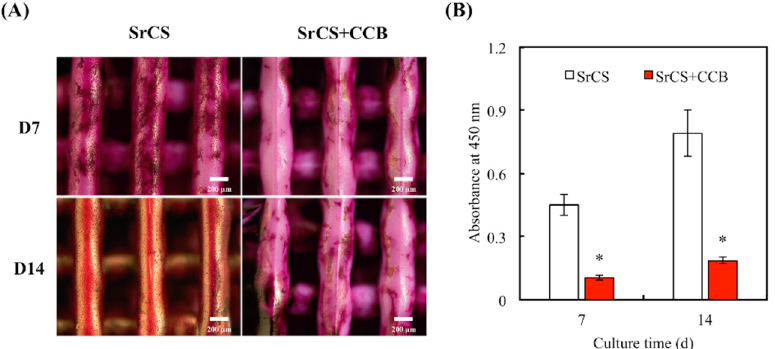
Figure 7. Proteins of ( A ) Col I, ( B ) OPN, and ( C ) OC secretion by WJMSCs were analyzed by enzyme-linked immunosorbent assay. Data presented as mean ± SEM, n = 6 for each group. “*” indicates a significant difference ( p < 0.05) when compared to SrCS.